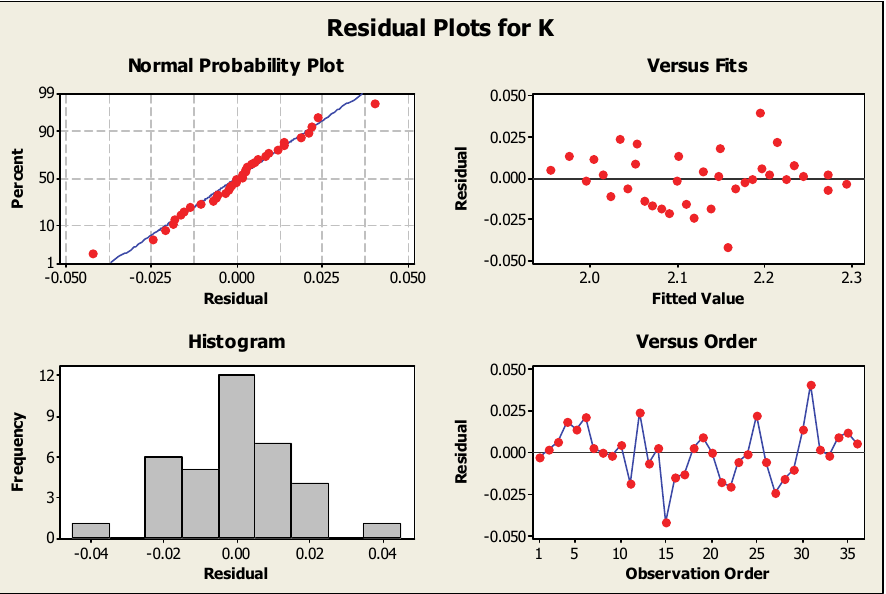
Fig. 5. Tests on the regression